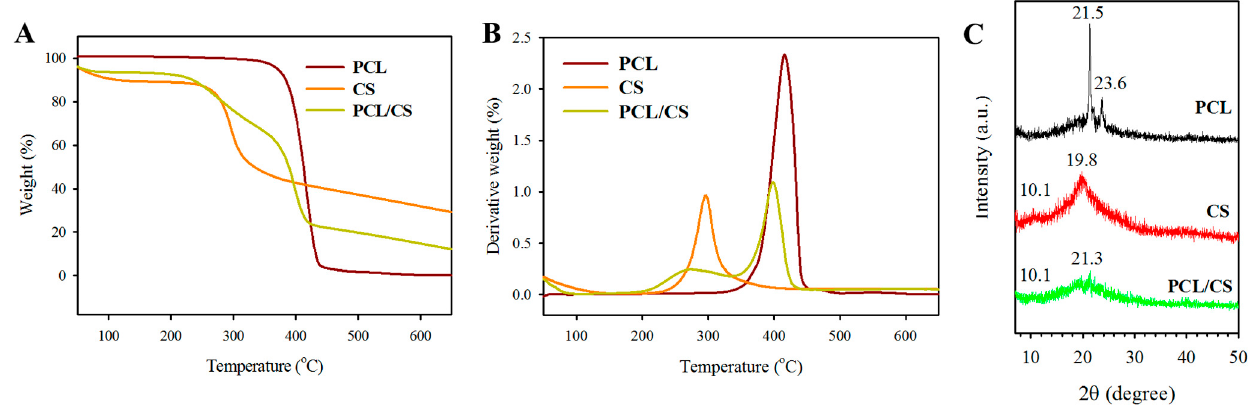
Figure 3. The thermogravimetric analysis (TGA) ( A ), derivative thermogravimetric analysis (DTA) ( B ) and X-ray diffraction (XRD) analysis ( C ) of PCL and PCL/CS nanofiber membranes. The CS polymer is used for comparison.